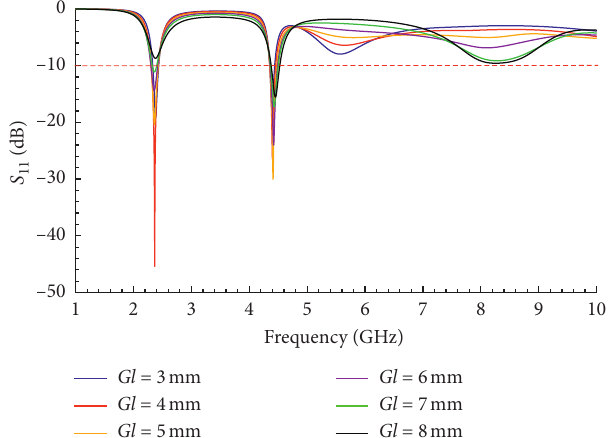
Figure 19: S 11 changes due to MPA.